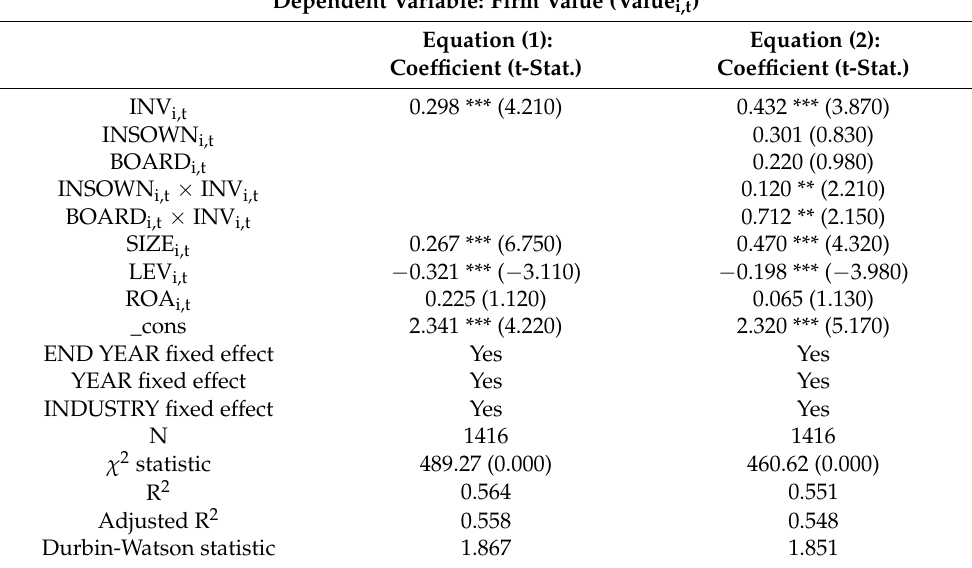
Table 4. GLS for the impact of investment efficiency, institutional ownership, and board independence on firm